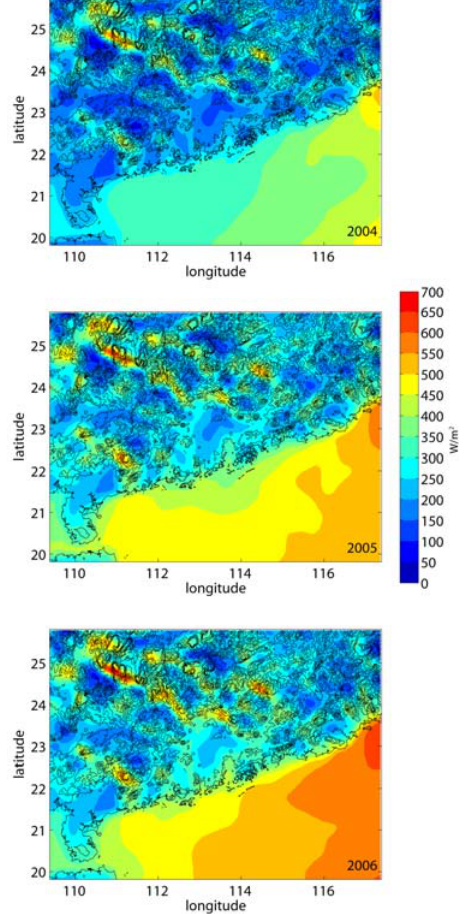
Figure 11. Wind power per unit area in (a) 2004, (b) 2005 and (c) 2006 at 60 m above ground over